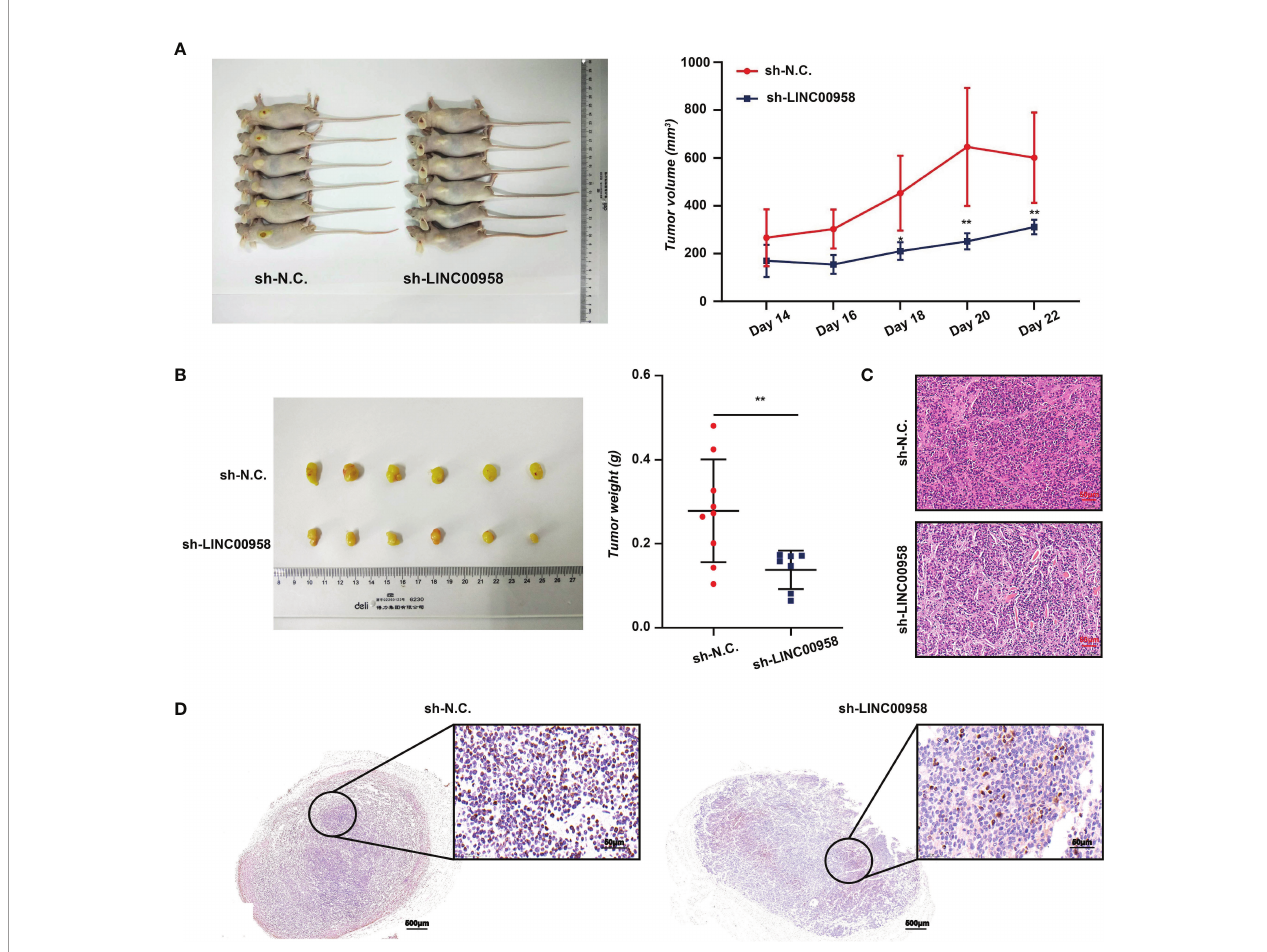
FIGURE 3 | Analysis of in vivo functions of LINC00958 in lung adenocarcinoma (LUAD) using a mouse xenograft model. (A) LINC00958 knockdown suppressed the tumor growth in xenograft mouse model generated by subcutaneously transplanting A549 cells transfected with sh-LINC00958 or sh-NC. into nude mice. The tumor volume was evaluated on days 14 – 22 post-transplantation. (B) LINC00958 knockdown decreased the tumor size and tumor weight in vivo . (C) Hematoxylin and eosin (HE)-stained sections of LUAD tumors derived from sh-LINC00958-transfected or sh-NC-transfected cells. (D) Representative images of Ki67 immunohistochemical analysis in the tumors derived from sh-LINC00958-transfected or sh-NC-transfected cells. * P < 0.05, ** P <